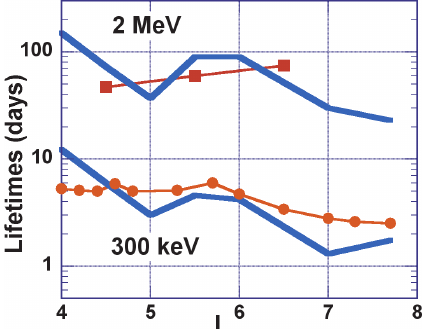
Fig. 21. Analytical lifetime estimates from L = 4 to 8 (blue curves) are compared with actual lifetimes measured by SAC-C, DEME- TER, and SCATHA (Benck et al., 2010; Su et al., 2012) for 300keV electrons and with lifetimes obtained during two pre-storm periods by model fitting to SAMPEX data (Tu et al., 2010) for 2MeV elec- trons. Lifetimes are estimated for lower-band chorus wave average amplitudes obtained from Cluster for moderate geomagnetic activ- ity (Kp ∼ 2).